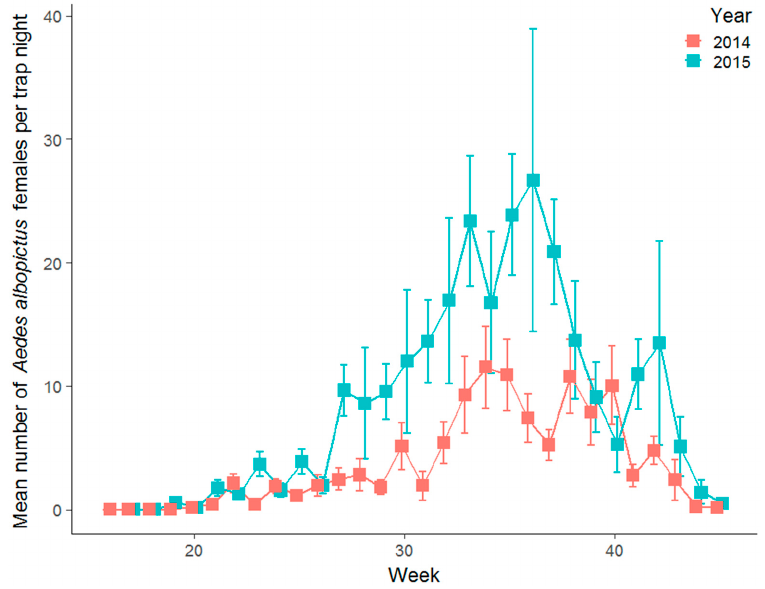
Figure 2. Mean number of Aedes albopictus females collected per trap night in 2014 and 2015 with BG- sentinel traps baited with BG lures and CO 2 . BG-sentinel traps baited with BG lures and CO 2 .